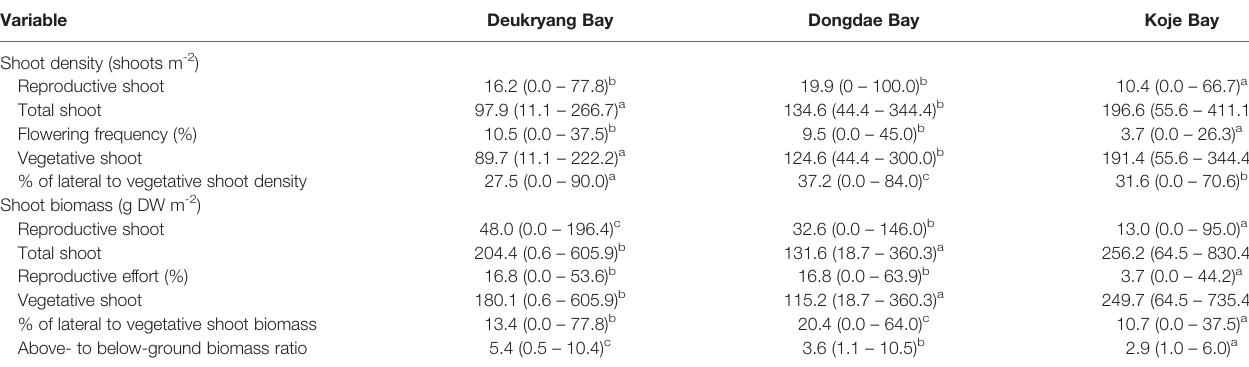
TABLE 2 | Zostera marina . Mean values of shoot density and biomass and the corresponding fl owering frequency and reproductive effort, the percentage of lateral shoot density to vegetative shoot density, the percentage of lateral shoot biomass to vegetative shoot biomass, and above- to below-ground biomass ratio in Deukryang Bay, Dongdae Bay, and Koje Bay on the southern coast of Korea.